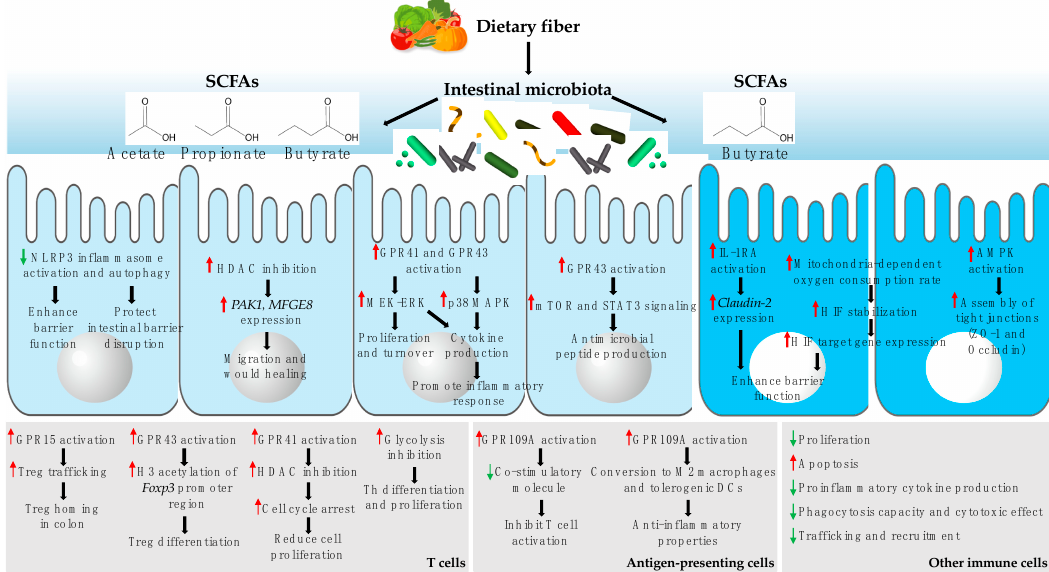
Figure 2. Dietary fiber-derived short-chain fatty acids (SCFAs) a ff ect intestinal epithelial cells (IECs) and immune cells. SCFAs derived from dietary fiber impact IECs through various mechanisms. These e ff ects include enhancing barrier functions, maintaining intestinal barrier integrity, inducing IEC migration and wound healing, promoting proliferation, turnover, and inflammatory responses, and inducing antimicrobial peptide production and the assembly of tight junction proteins. In addition, SCFAs a ff ect immune cells, including T cells, antigen-presenting cells, and others such as monocytes and macrophages. SCFAs induce the di ff erentiation and tissue homing of regulatory T cells (Tregs), promote the cell proliferation and di ff erentiation of helper T (Th) cells, modulate the function of antigen-presenting cells, and alter other immune cell properties. Abbreviations: NLRP3, NOD-like receptor pyrin domain-containing protein 3; HDAC, histone deacetylase; PAK1, p21 activated kinase; MFGE8, milk fat globule-EGF factor 8; GPR, G-protein coupled receptor; MAPK, mitogen-activated protein kinase; Treg, regulatory T cell; Th, helper T cell; DCs, dendritic cells.